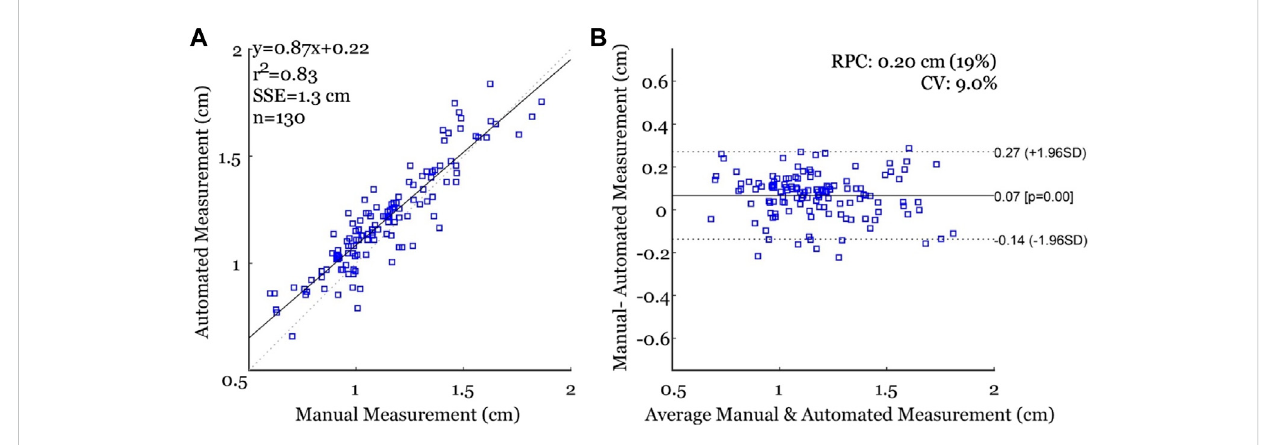
FIGURE 4 Correlation plot with Pearson R value squared (A) and Bland-Altman plot (B)